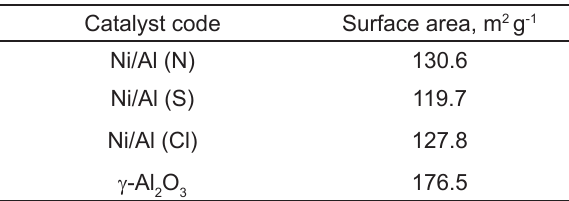
Table 2. BET surface areas of the obtained catalysts of Ni/Al (N), Ni/Al (S) and Ni/Al (Cl) Catalyst code